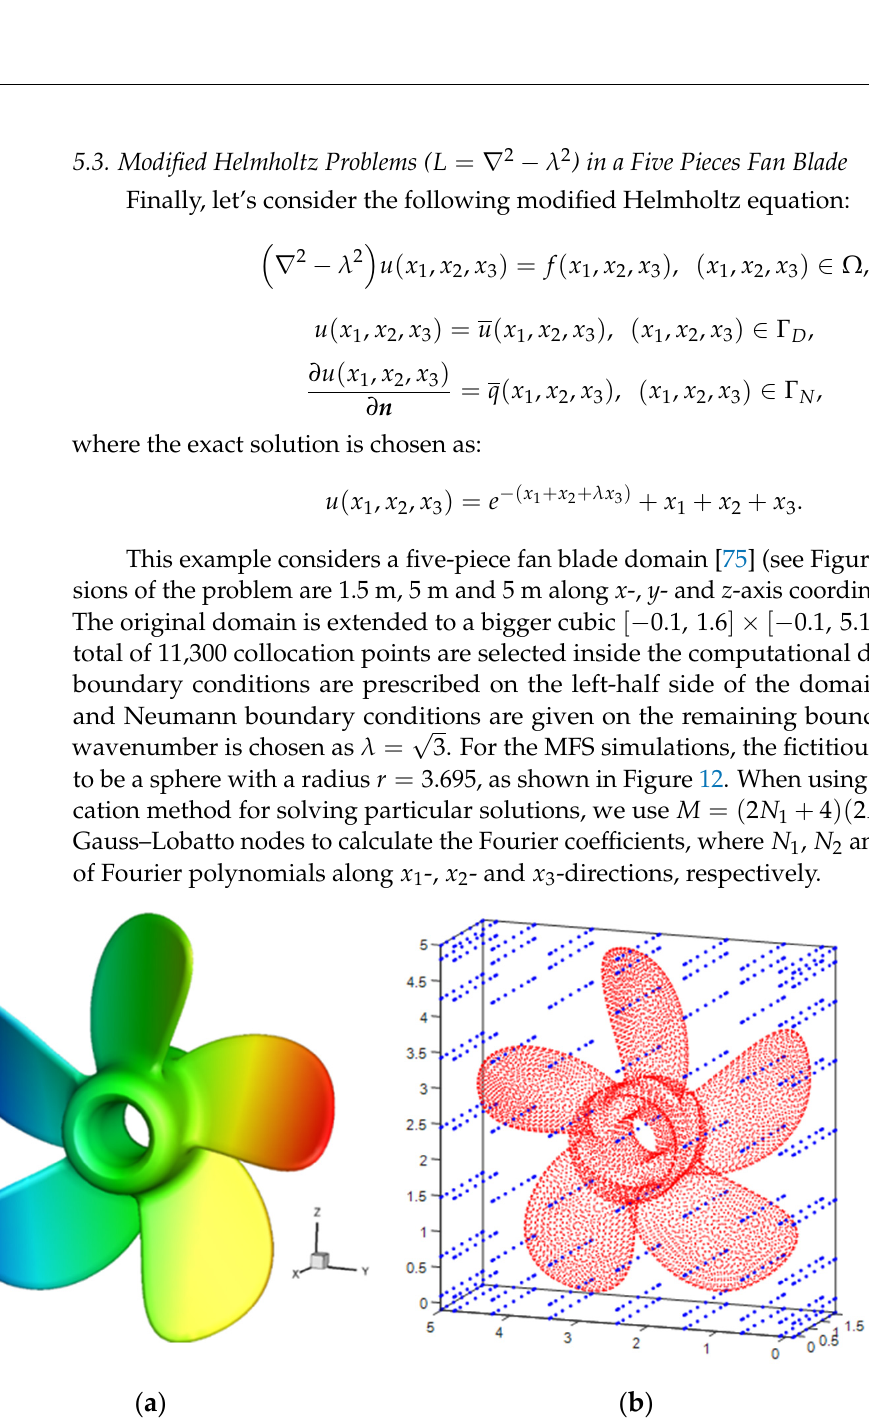
Figure 11. Geometry of the problem ( a ) and the distribution of the shifted Gauss–Lobatto nodes ( b ).